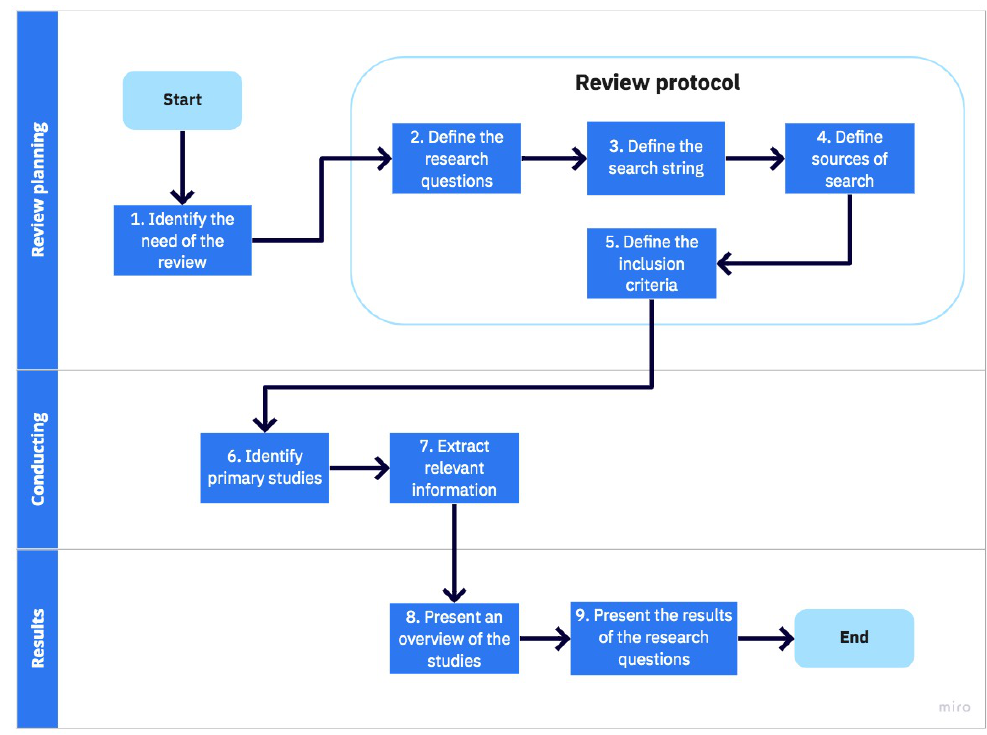
Figure 1. Methodology to select papers in this systematic